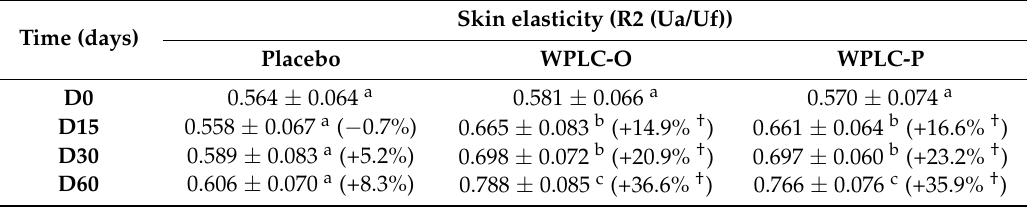
Table 7. Skin elasticity results after 15, 30 and 60 days of supplementation with WPLC-O and WPLC-P measured by Cutometer ® . Data are averages ± SD in elasticity values R2